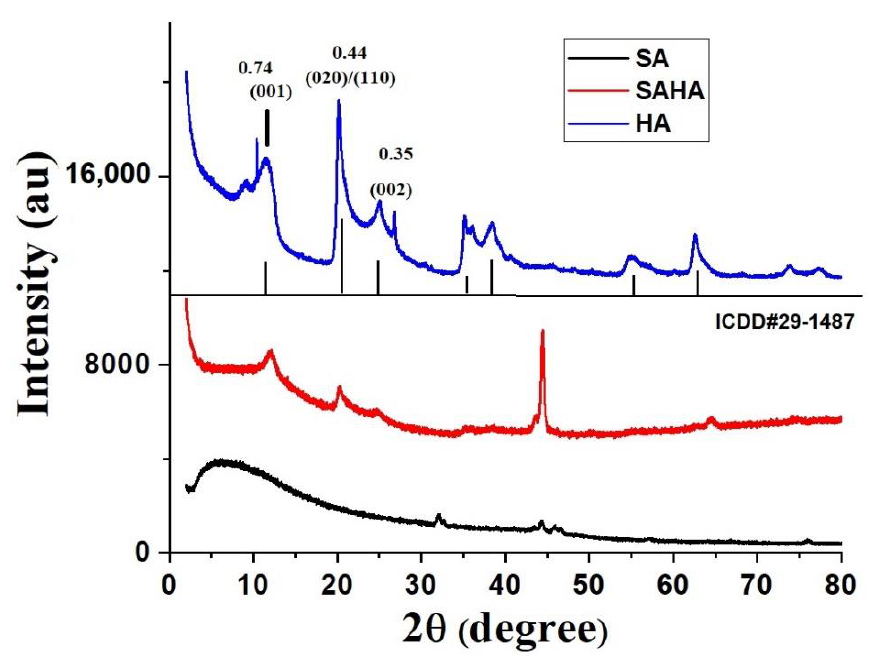
Figure 2. XRD patterns of the as-prepared alginate–halloysite composite aerogels.